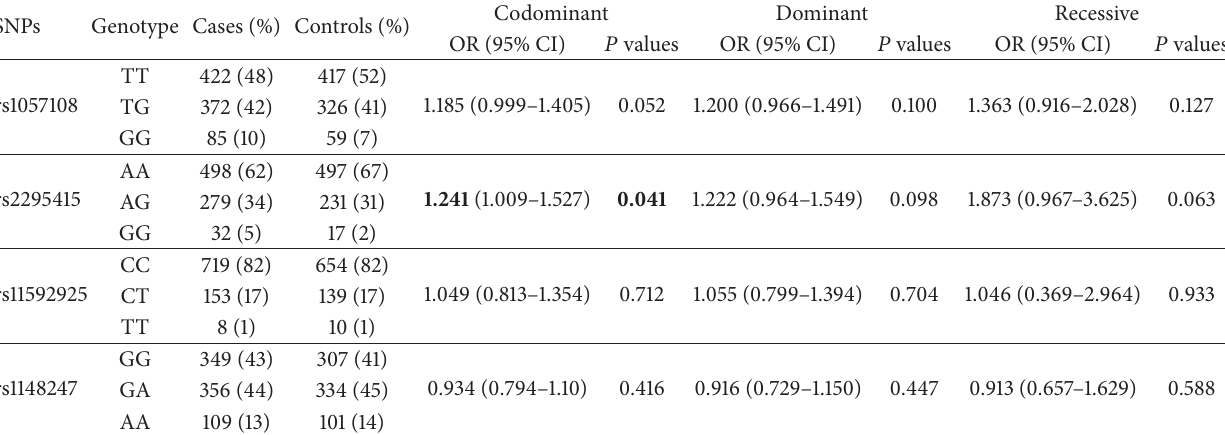
Table 3: Genotype analysis of CREM 𝛼 tagSNPs in SLE association, adjusting for sex and age. SNPs